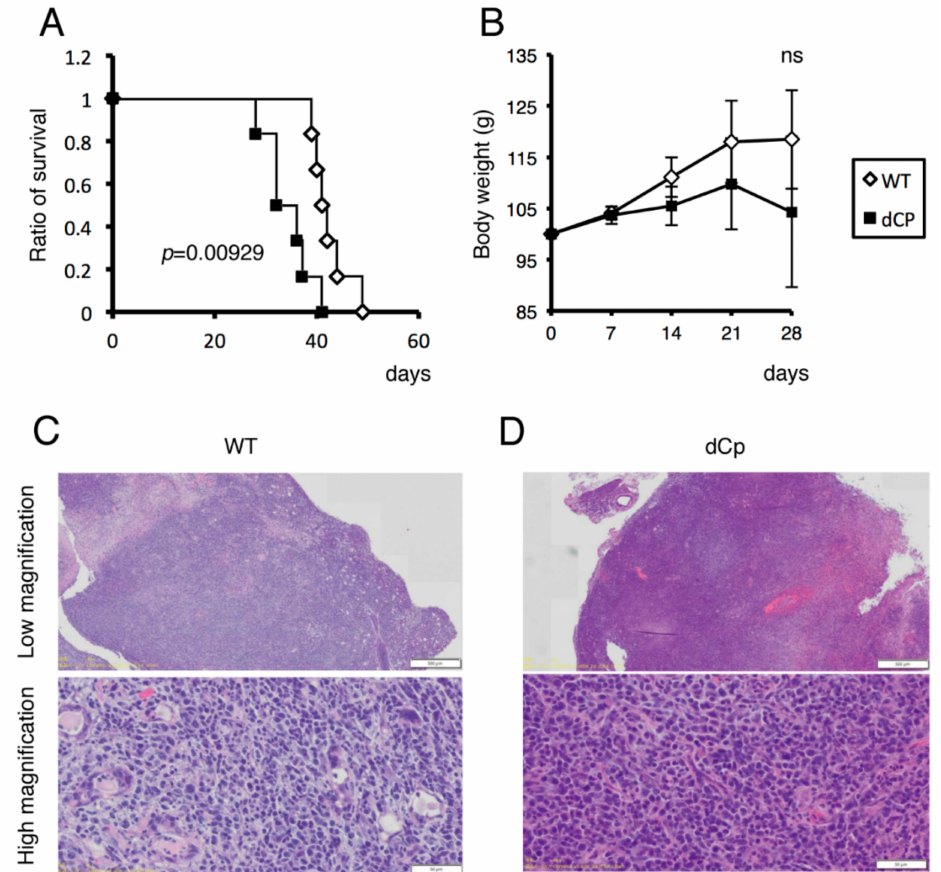
Figure 4. Survival of xenograft mice with EBV-associated lymphoproliferative disorder. First, 1.0 × 10 7 human cord mononuclear blood cells were each infected with 1.0 × 10 4 viruses (WT, dCp) and immediately transplanted intraperitoneally into NOG mice ( n = 6). ( A , B ) Survival ratio ( A ) and body weight ( B ) of the mice were plotted. ( C , D ) Microscopic images of H-E staining of tumors in the pancreas of the mice infected with WT ( C ) or dCp ( D )